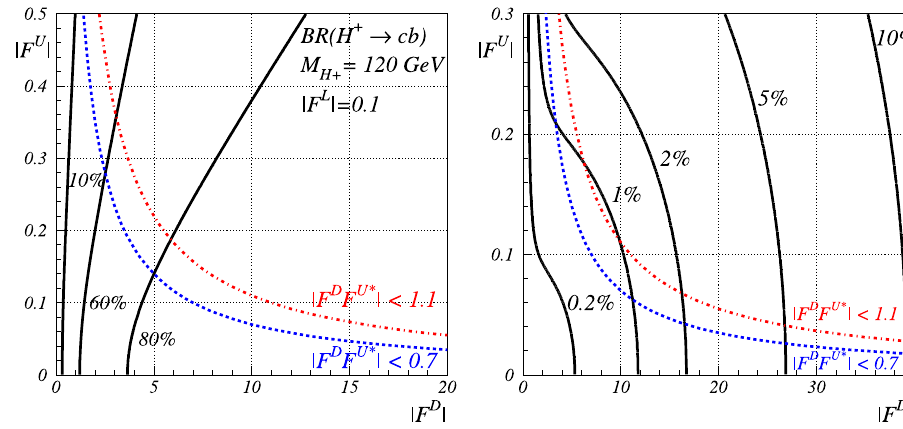
Fig. 27 Left Contours of BR ( H + → cb ) in the | F D | – | F U | -plane with 1 1 | = 0 . 1. The B → X γ | F L s 1 constraint removes the region above the red or blue hyperbolas; see the text. Note that the two scales on the axes are very different. Right Contours of BR ( t → H + b ) × BR ( H + → cb